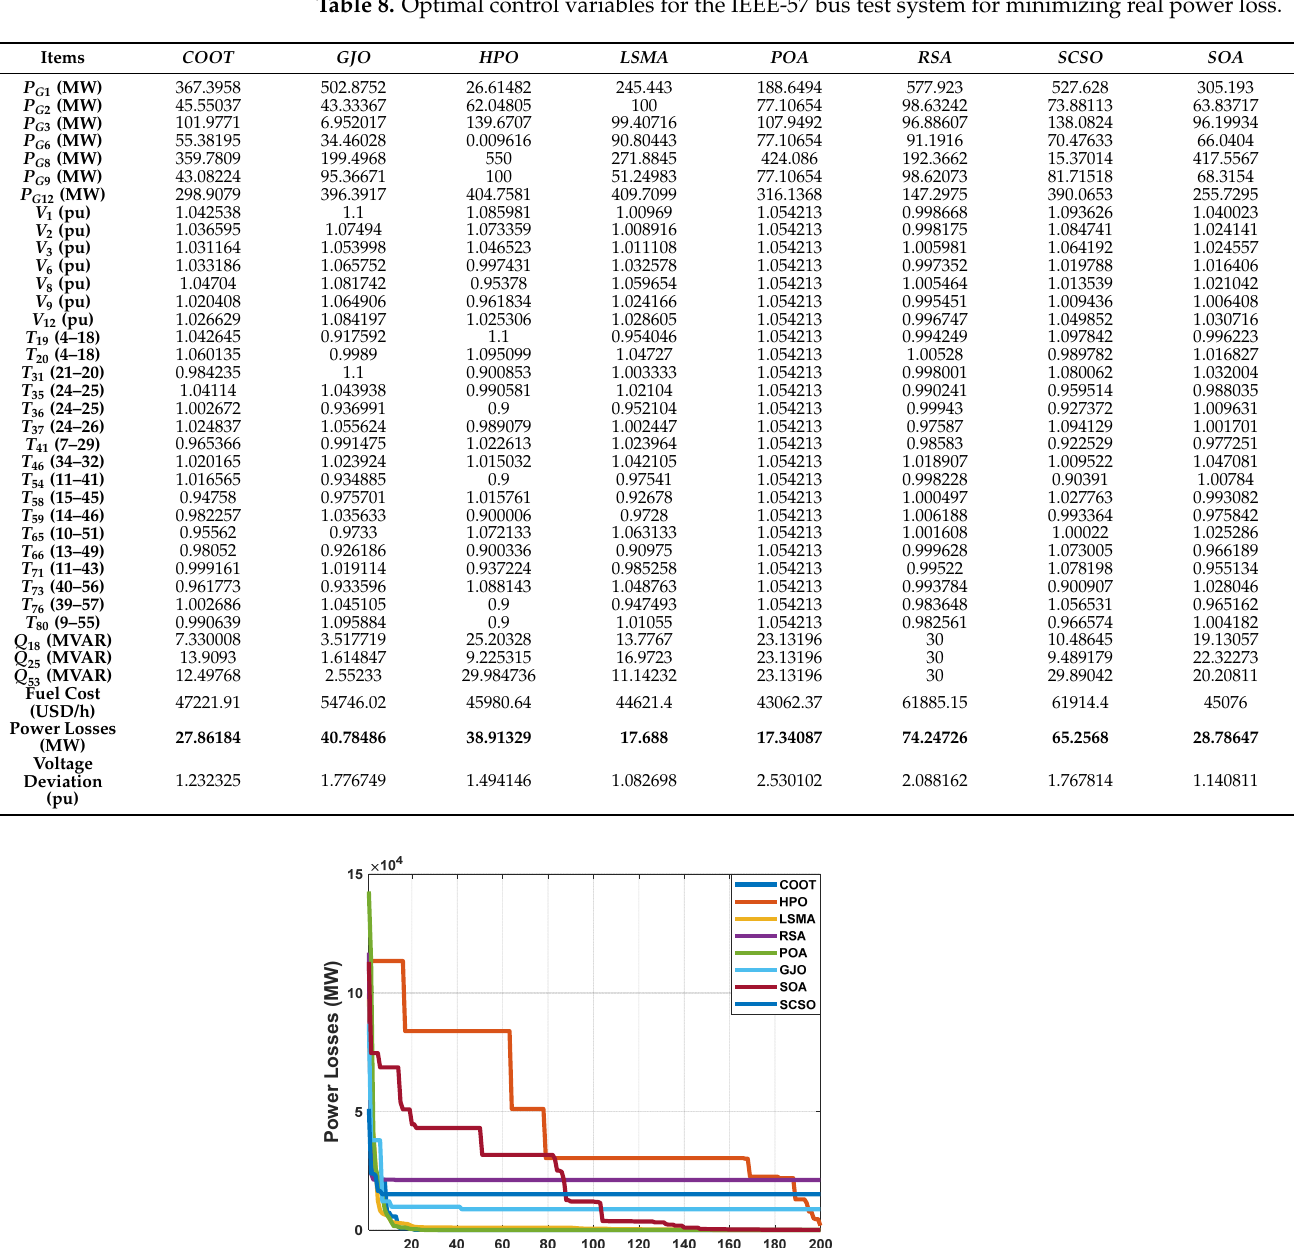
Table 8. Optimal control variables for the IEEE-57 bus test system for minimizing real power loss.